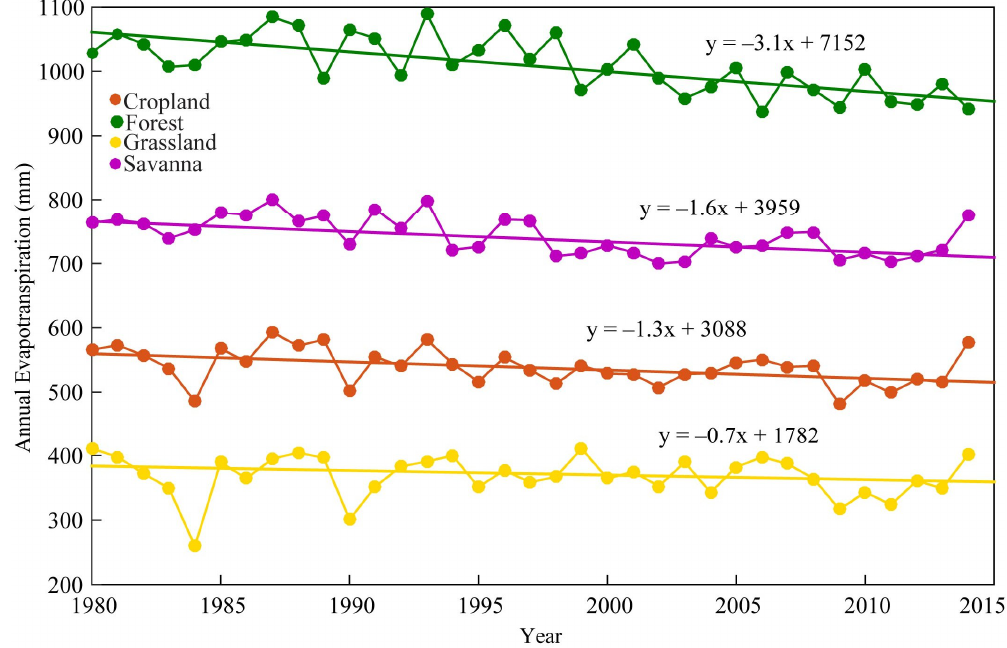
Figure 7. Interannual variations in total ET during 1980–2014 in four vegetation types of the Nile River Basin. Positive (negative) signs indicates an increasing (decreasing) trend. Basin. Positive (negative) signs indicates an increasing (decreasing)